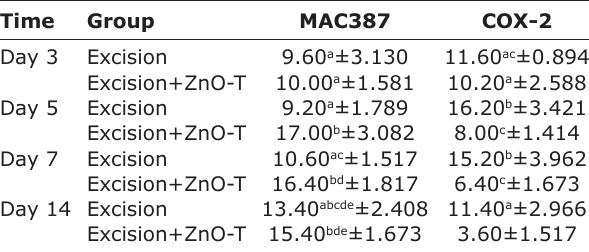
Table-1: Comparison of MAC387 and COX-2 expression.